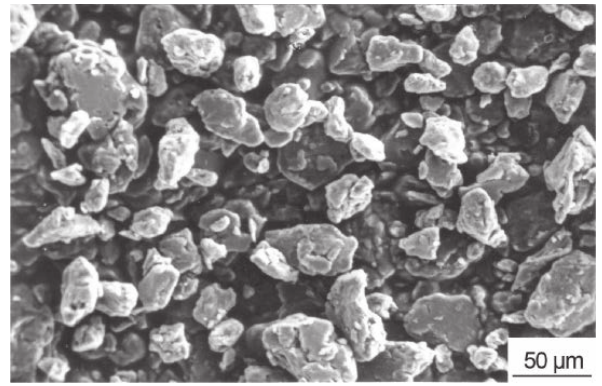
1. Plastic deformation and deformation strengthening of the starting Al powders and their transformation to Al lamellae.